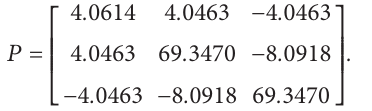
In Figure 7, the trajectories of ς k ( t ) , ( k � 1 , 2 , . . . , 8 ) are depicted, where the curves formed by circle markers